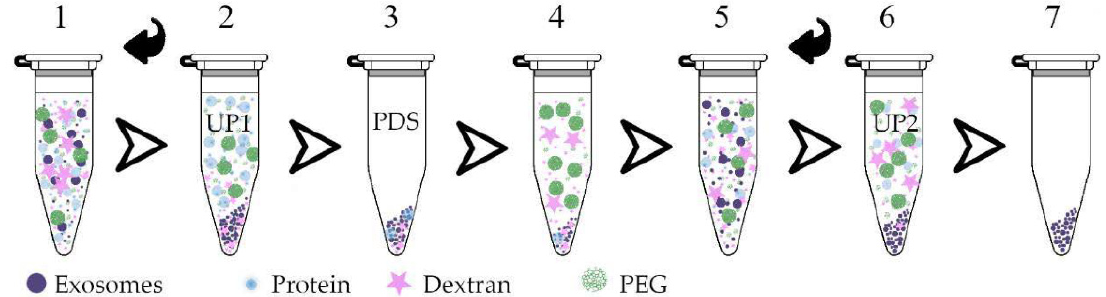
Figure 4. The workflow of an aqueous two-phase system (ATPS)-based EV isolation. Dextran (DEX) and PEG were added into plasma. After mixing and centrifugation, two phases formed with the upper phase (UP1) containing PEG and proteins. After removing UP1, a protein-depleting solution (PDS) was left and then mixed with PEG/DEX again. The lower phase containing DEX and EVs was collected after mixing, centrifugation and removing the PEG-rich phase again. This figure was adopted from reference [82].